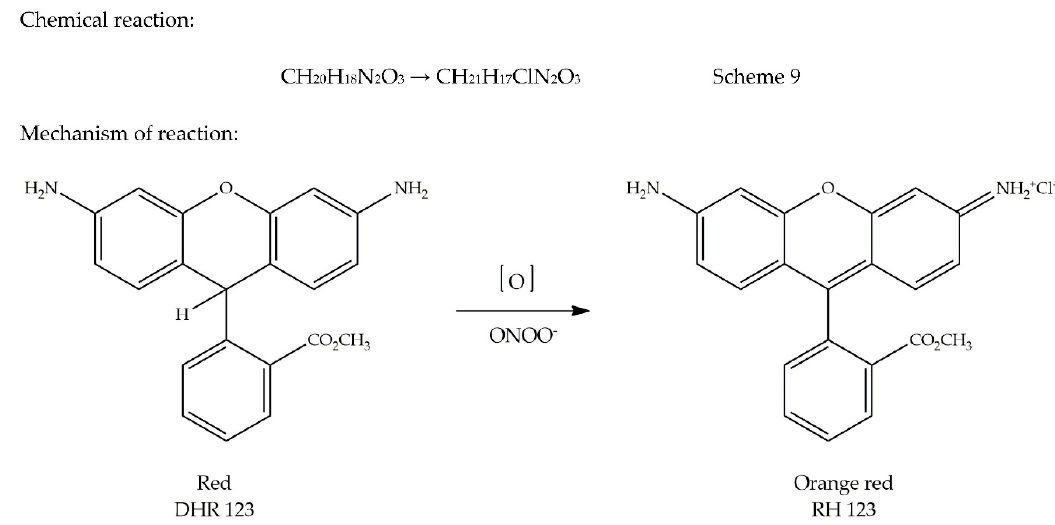
− reaction Figure 8. ONOO − reaction mechanism. Figure 8. ONOO